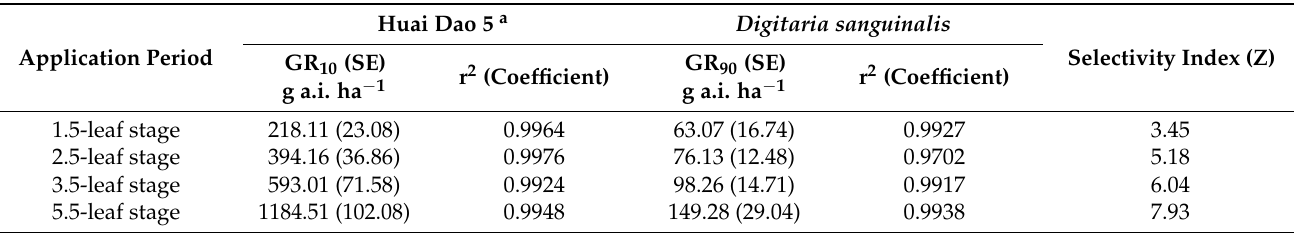
Table 6. Selectivity index of Glyamifop between rice and weeds.